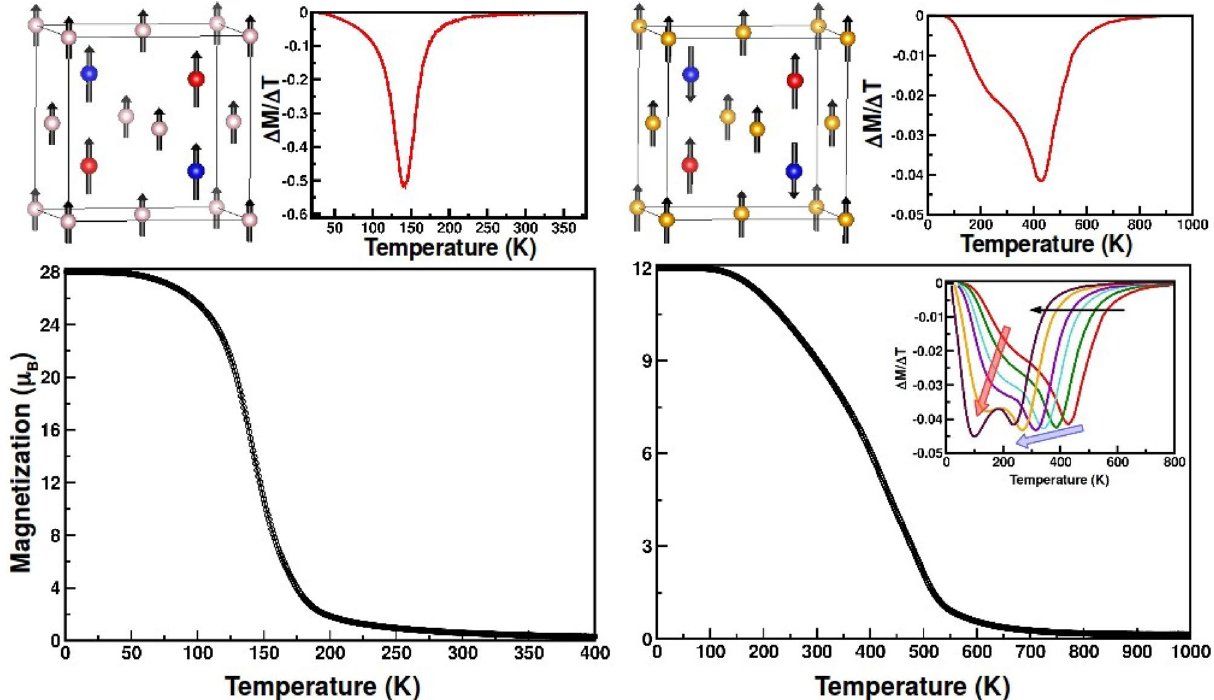
Figure 5. Magnetic properties of CMNRO (left) and CMCRO (right) obtained from Monte-Carlo simulation. Top, left panels show the ground state magnetic structures, while the top, right panels show the derivative of magnetization as a function of temperature, the minimum corresponding to the transition temperature of the corresponding compound. Mn1, Mn2, Ni(Co) atoms are represented by red, blue and light pink (yellow) balls respectively. The lower panels shows the magnetization plotted as a function of temperature. The inset in lower, right panel shows the shift of transition temperature (the minima of the curves) for monotonic decrease of D Mn 1 − Co . For details see